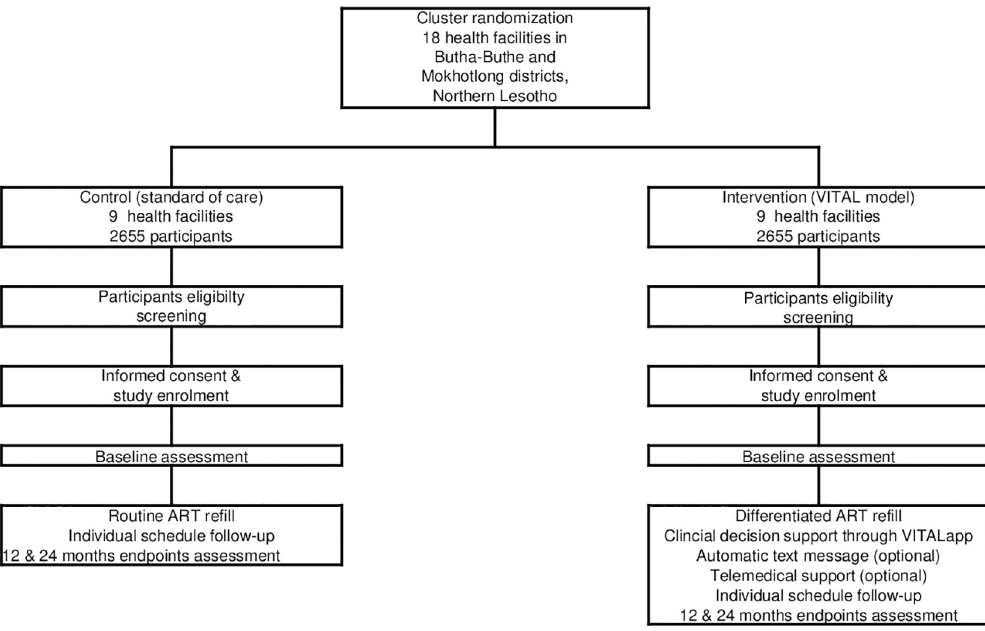
Fig 2. Flow chart of study